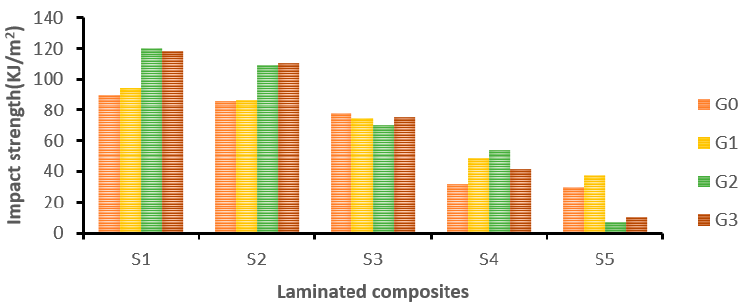
Figure 9. The e ff ect of GNP on the impact strength of laminates. Figure 9. The effect of GNP on the impact strength of laminates. Table 8. The test results of impact strength.